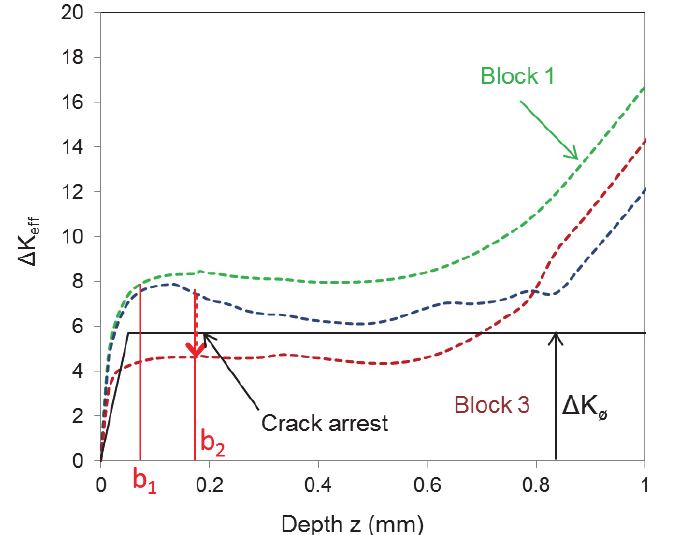
Figure 10 : Evolutions of Δ K eff of each loading blocks as a function of depth.